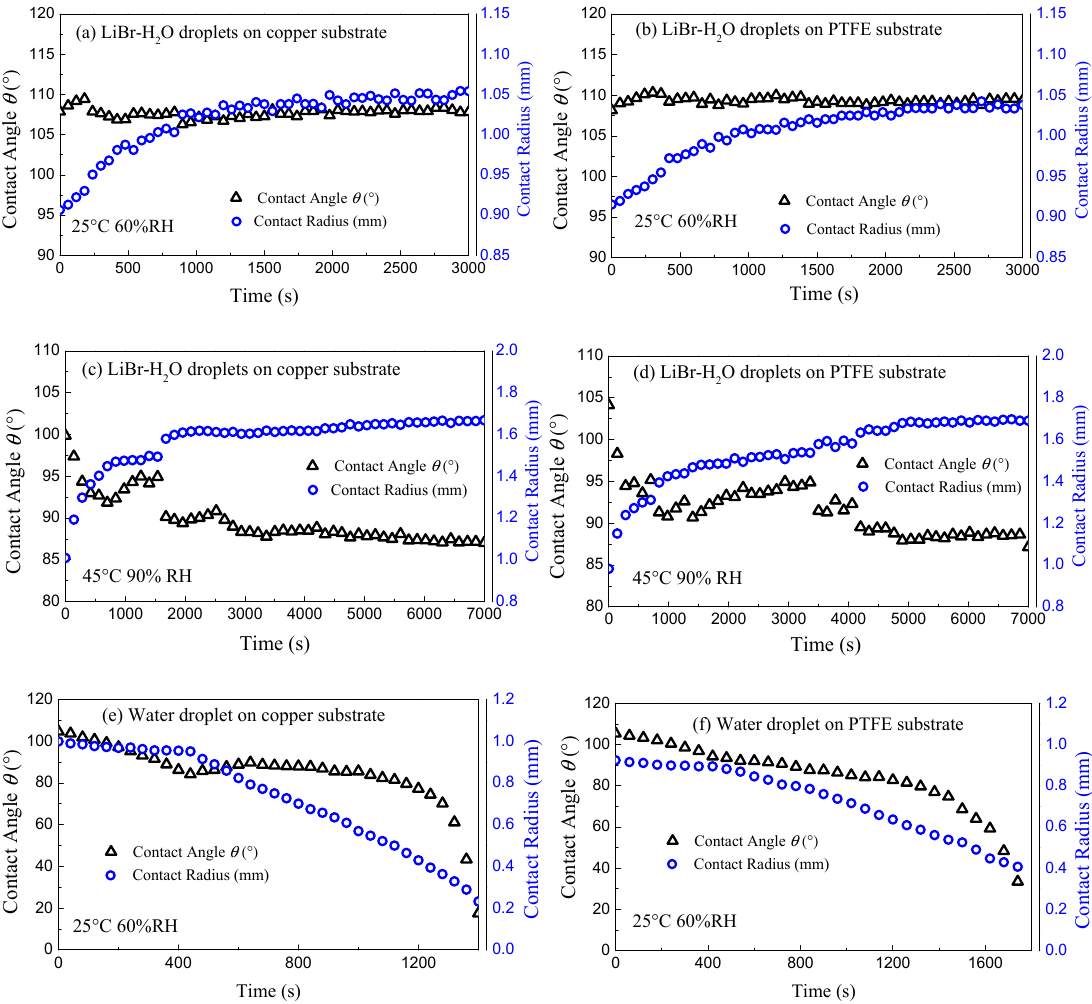
Figure 2 . Evolution of contact angle θ (black triangles points) and contact radius r (blue circles points) of LiBr-H 2 O ( a – d ) and pure water droplets ( e,f ) on copper ( a,c,e ) and PTFE ( b,d,f ) substrates coated with FEP for 25 °C—60% RH ( a,b,e,f ) and 45 °C—90% RH ( c,d ) conditions.